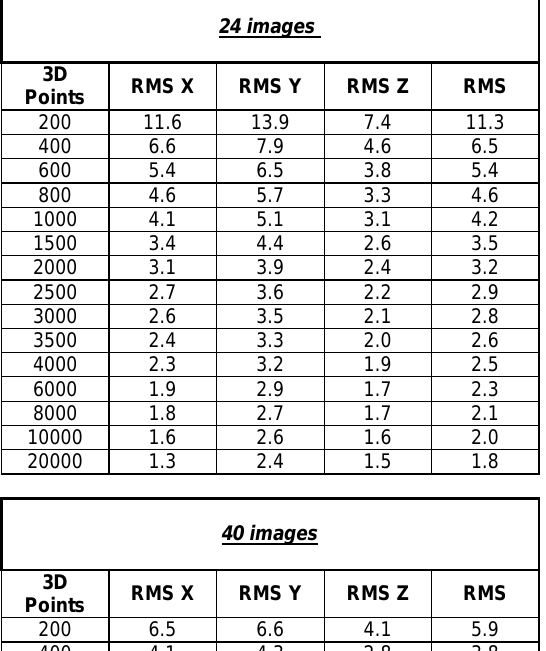
Figure 3. The relationship between number of 3D points and